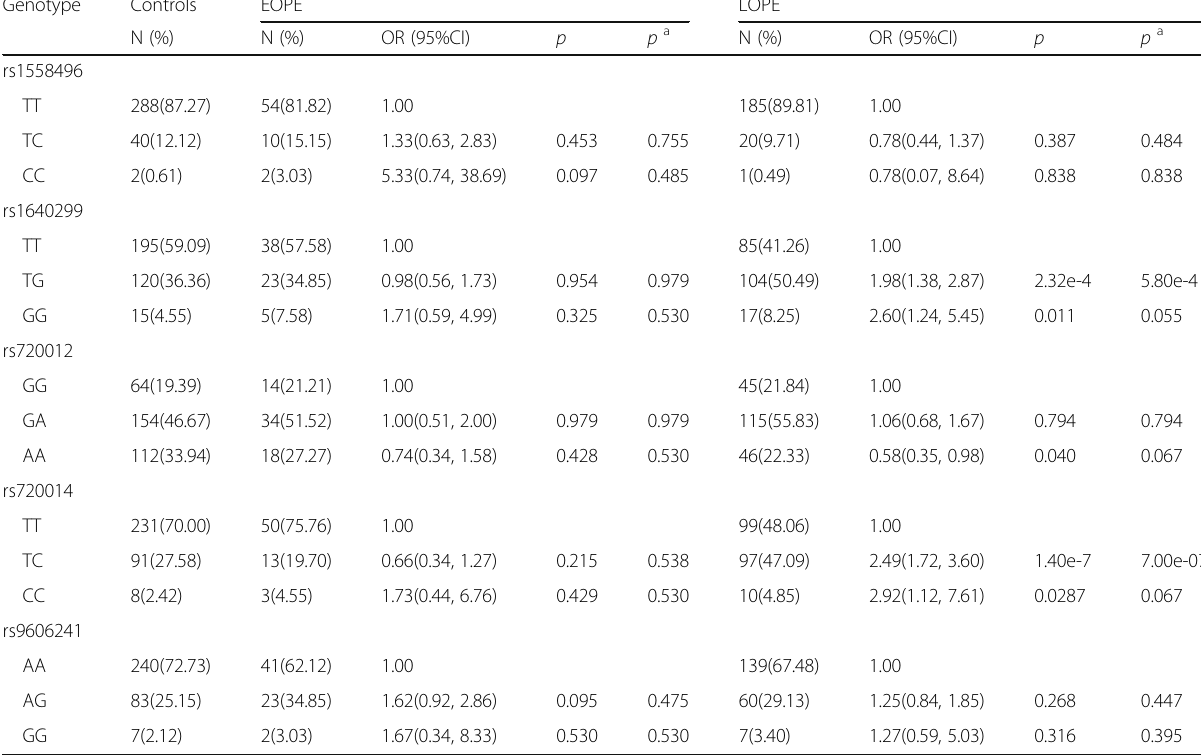
Table 2 Associations between the polymorphisms in DGCR8 gene and preeclampsia subtypes Genotype